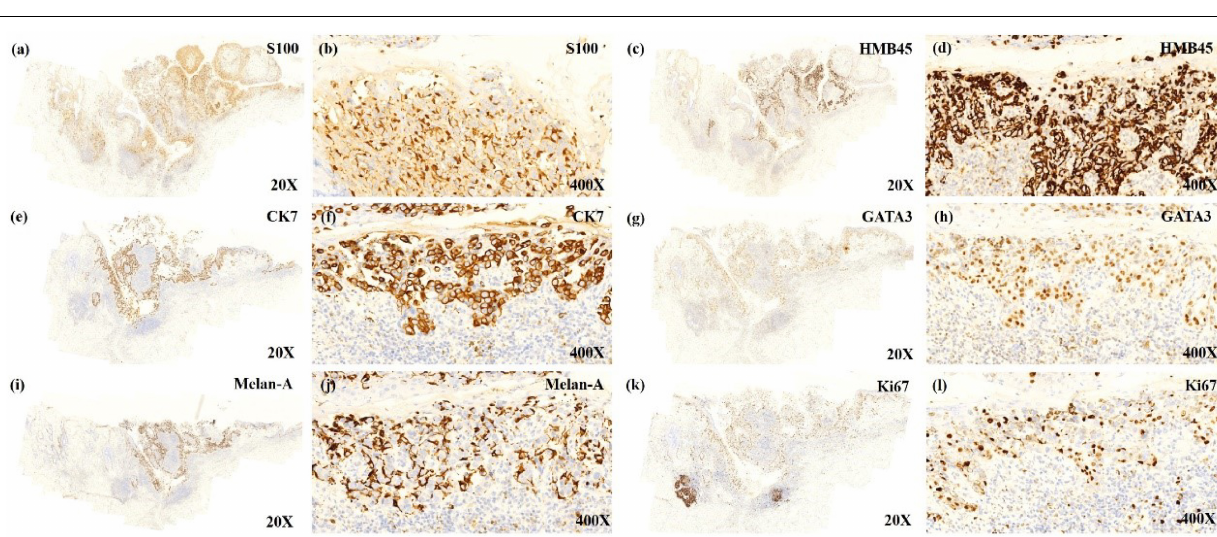
FIGURE 2 | The low power view shows tumor cells expressing the immunoreactivity of S100 (a) , HMB45 (c) , CK7 (e) , GATA3 (g) , MelanA (i) , Ki67 (k) . The positively expressed cells that almost localize on the same place seem to make the diagnosis of malignant melanoma (MM) in situ with Paget disease to be established. The high power view shows immunoreactive cells of S100 (b) , HMB45 (d) , CK7 (f) , GATA3 (h) , and Ki67 (l) , indicating that these cells are Paget cells expressing S100 and HMB45. Melan-A positive expressed cells (j) mostly surrounded Paget cells, and the stain was mostly positive on the dendritic spine of proliferated melanocytes, implying proliferated